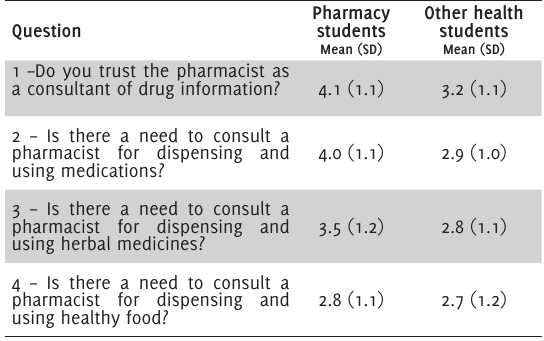
Table 2: Responses of pharmacy, nursing, applied medical science, medical, and dentistry students regarding knowledge of medication use by percent and frequency (N=204)